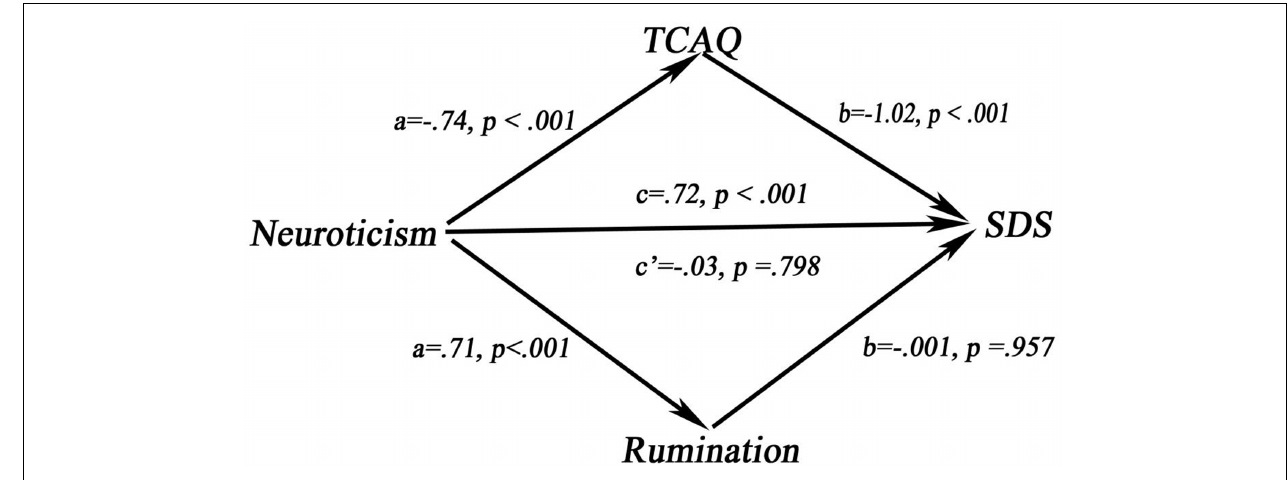
FIGURE 3 | The mediating model in